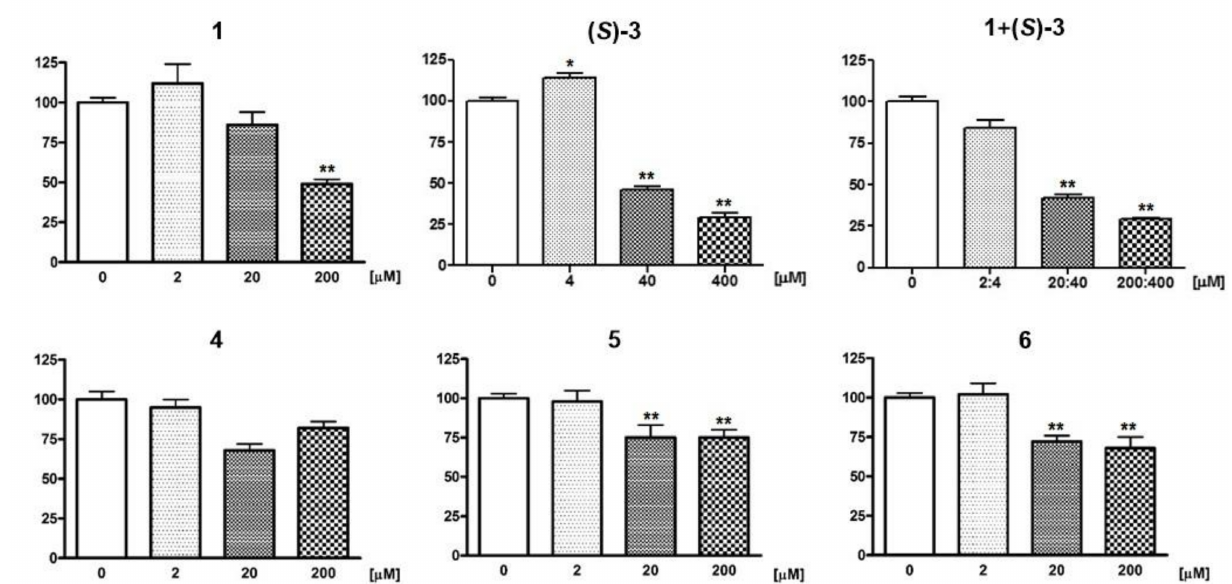
Figure 3. Cell viability determined by MTT assay. Primary rat cerebellar granule neurons (CGNs) treated with conjugates 4 – 6 in comparison with controls; cromolyn ( 1 ), ( S )-ibuprofen ( ( S )-3 ) and their 1:2 combination ( 1 + ( S )-3 ) for 24 h. Results are expressed as percentages of controls and are the mean ± SE of at least 3 independent experiments, each run in triplicate. * p < 0.05 ** p < 0.01 compared to control conditions (0 µ M), Dunnett test after one-way